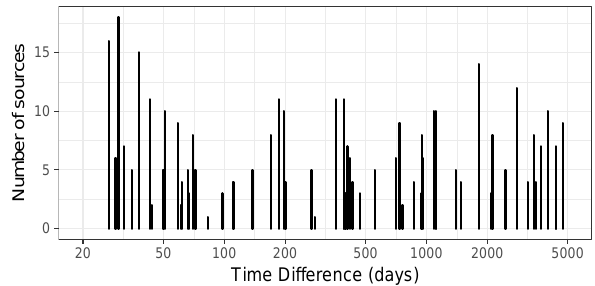
Fig. 1.— The separation in time between pairs of observations used to construct the sample question: given a measurement of the X-ray flux of an AGN at some epoch, but no knowledge of its redshift or nature, what is the uncertainty on its flux at a second epoch due to its intrinsic